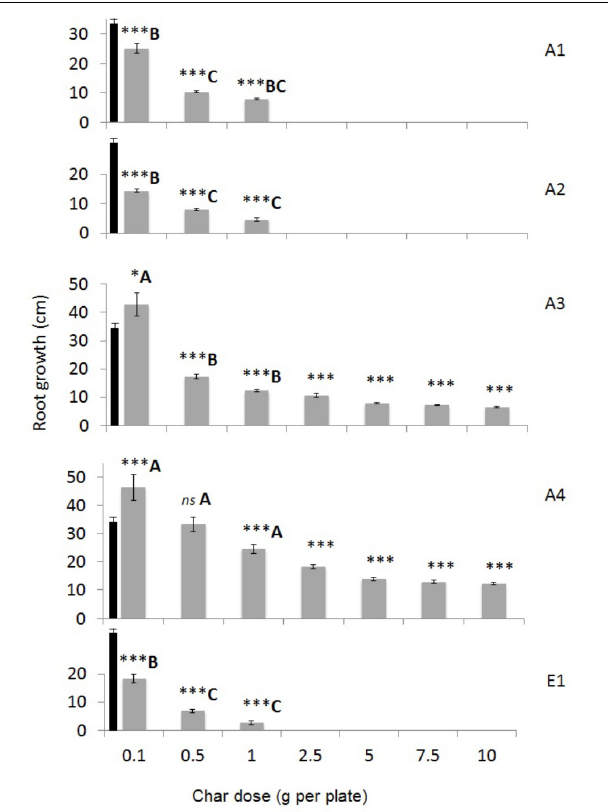
FIGURE 8 | Deconvoluted X-ray emission spectra acquired from biochars A3 and A4. The electron beam energy was set at 20 KV, and the acquisition live time at 60 s. In each spectrum, the X axis represents the X-ray energy in eV, and the Y axis represents the peak intensity.